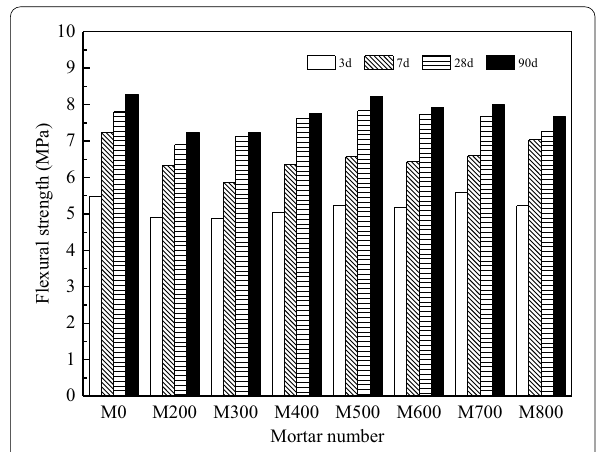
Fig. 9 Flexural strength of attapulgite